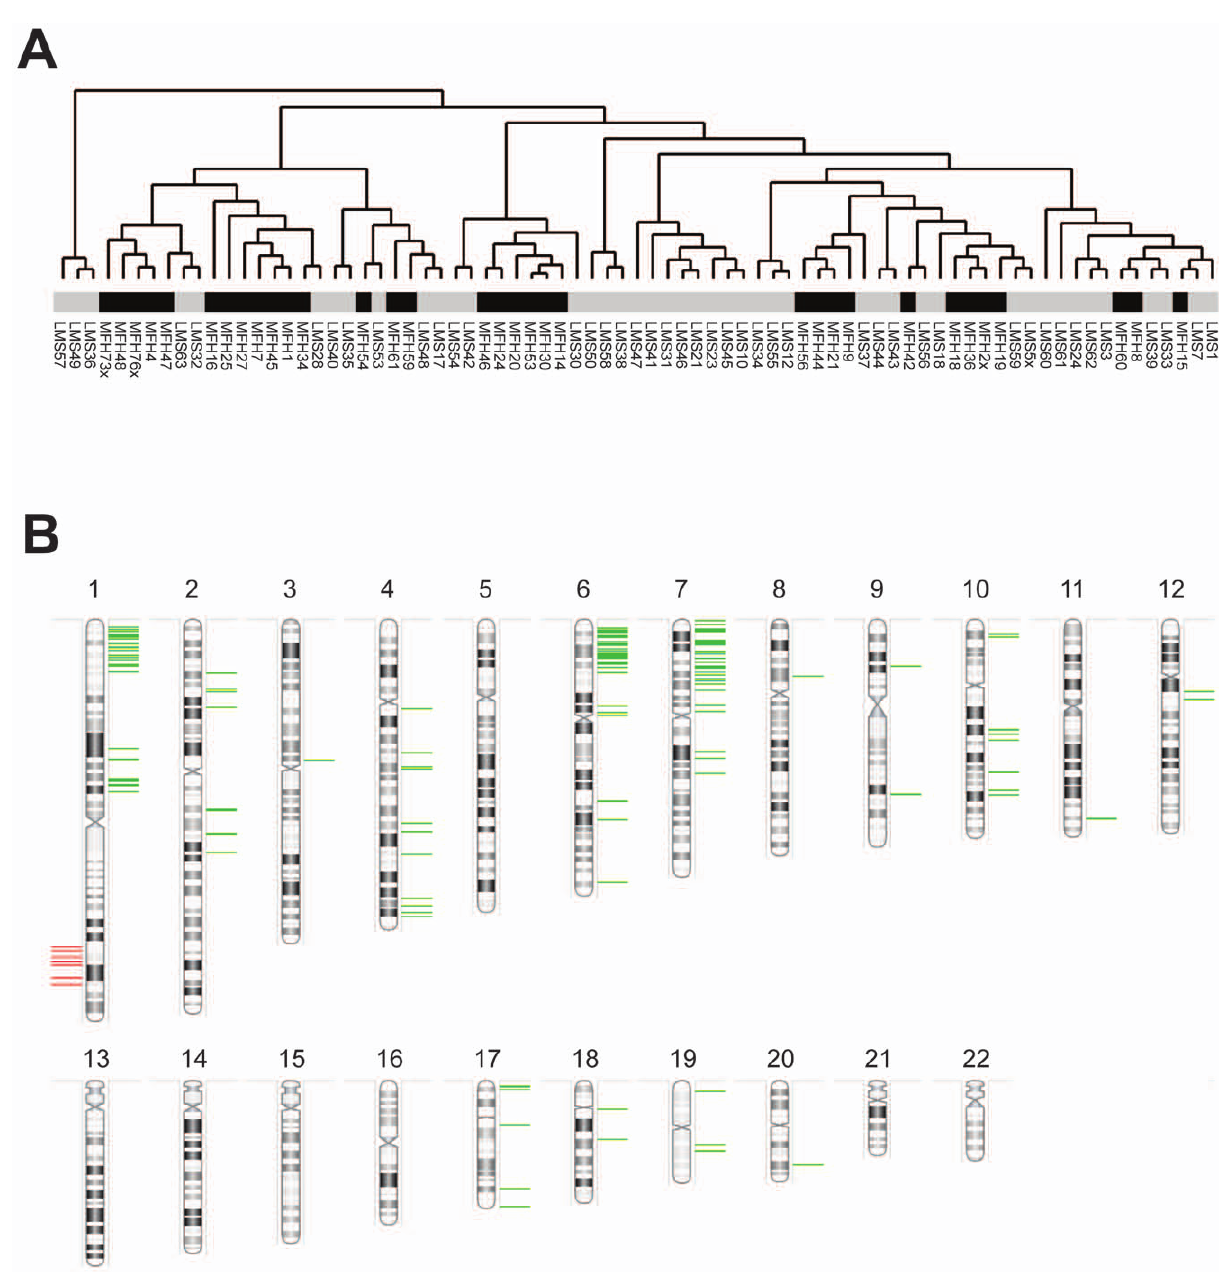
Figure 4. Comparison between MFHs and leiomyosarcomas. ( A ) Hierarchical clustering dendogram of 33 MFHs and 44 leiomyosarcomas using DNA copy number ratios relative to a pool of normal diploid DNA. Black, MFHs; grey, leiomyosarcomas. ( B ) Graphical representation of genomic clones identified by SAM to be significantly different between the MFHs and leiomyosarcomas. The lines represent the chromosomal position of the 156 identified genomic clones. Green, higher copy number in MFHs compared to leiomyosarcomas; red, lower copy number.